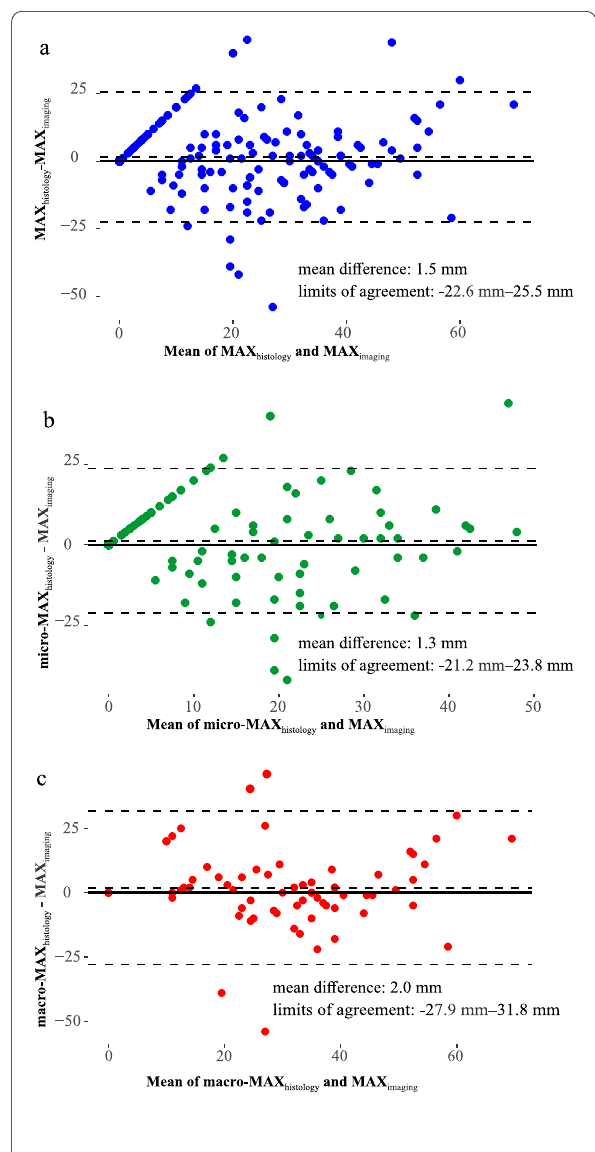
Fig. 5 Bland–Altman plots depicting the difference in histological tumor size and MRI‑assessed tumor size: for MAX histology and MAX imaging ( n 212) ( a ), tumor size based on microscopy = (micro‑MAX histology ) and MAX imaging ( n 158) ( b ) and tumor size based = on macroscopic assessment (macro‑MAX histology ) and MAX imaging ( n 72) ( c ). Mean MAX histology was 1.5 mm larger than MAX imaging ( a ), = mean micro‑MAX histology was 1.3 mm larger than MAX imaging ( b ), and mean macro‑MAX histology was 2.0 mm larger than MAX imaging ( c